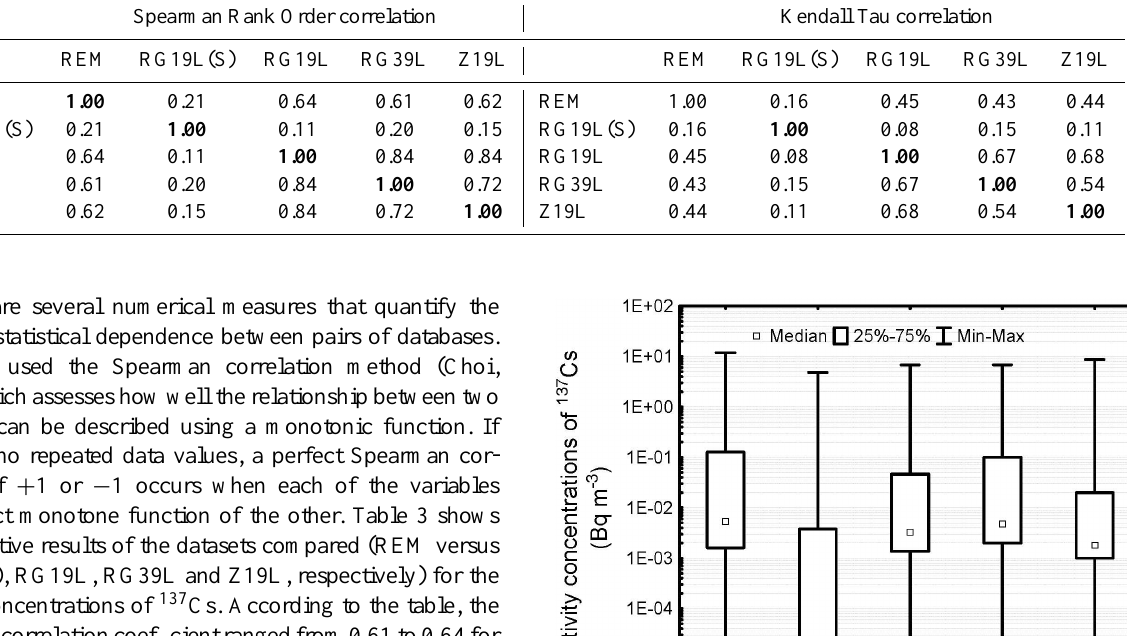
Table 3. Comparison of the activity concentrations of 137 Cs from the Chernobyl accident between the REM database and the different model versions used (RG19L(S), RG19L, RG39L and Z19L). Spearman Rank Order and Kendall Tau correlations ( R 2 ) between the datasets ( N = 711) for 95% confidence level ( p < 0.05). Spearman Rank Order correlation